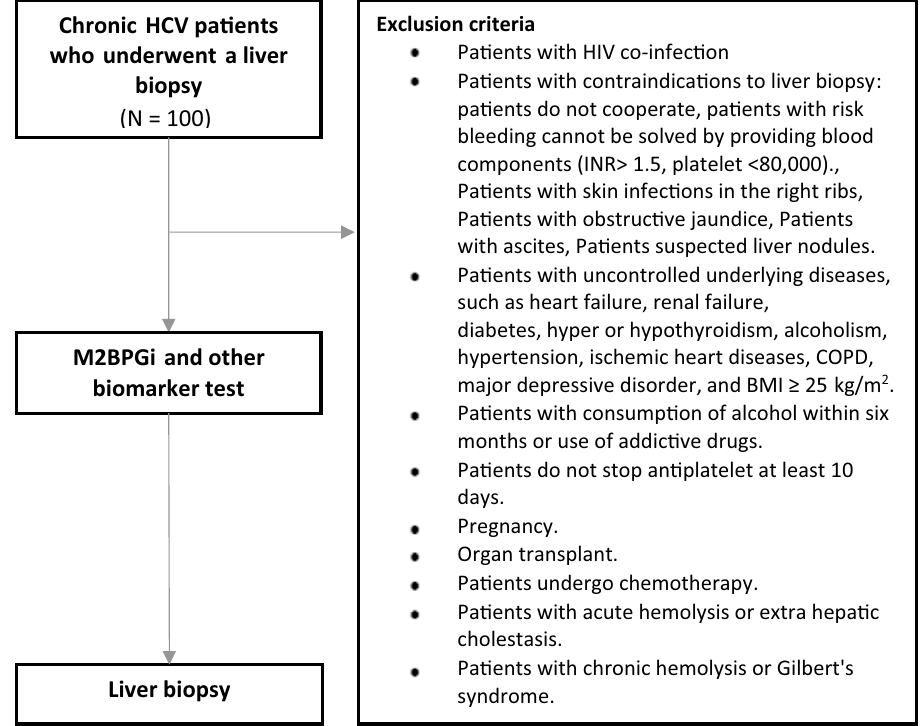
Figure 1. The study design to investigate the usefulness of M2BPGi in Thai liver disease